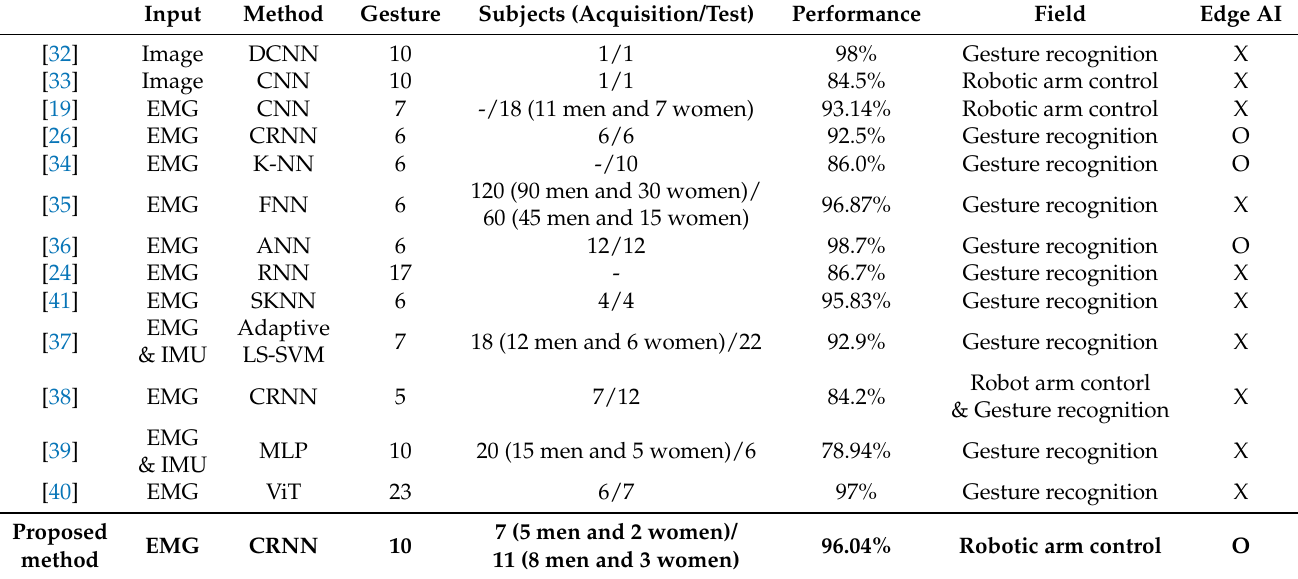
Table 4. Comparisons to previous studies. (X: Not used, O: